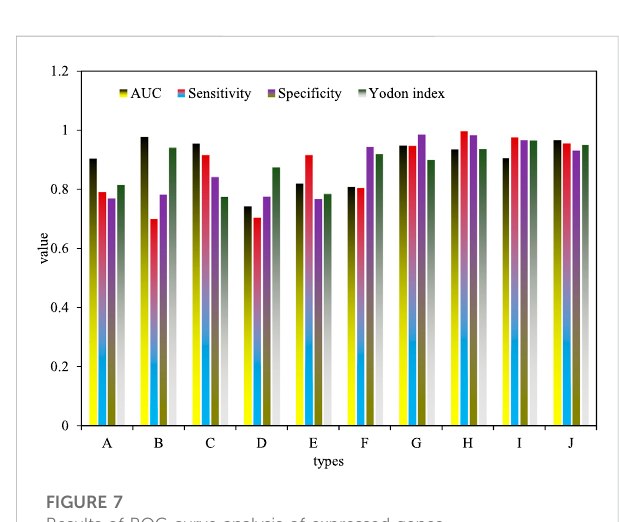
FIGURE 7 Results of ROC curve analysis of expressed